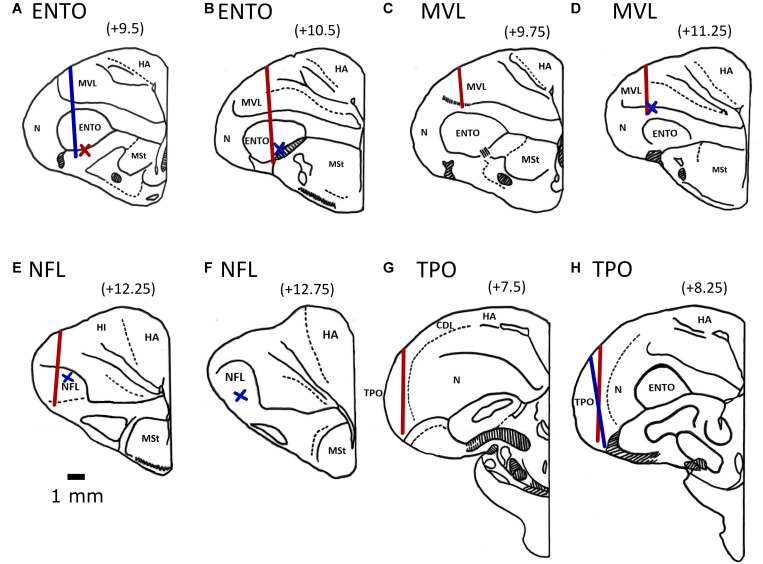
Electrode track position reconstructions for the two ENTO birds at AP + 9.5 (A) and AP + 10.5 (B), the MVL bird at AP 9.75 (C) and two birds at AP + 11.25 (D), two NFL birds at AP + 12.25 (E) and one bird implanted at AP + 12.75 (F), the TPO bird implanted at AP + 7.5 (G) and two birds implanted at AP + 8.25 (H). Both left and right electrode tracks are displayed on the same section. Tracks for birds with implants in the left hemisphere are displayed by the blue line and for birds with implants in the right hemisphere by a red line. We determined the termination point of electrode tracks that were unable to be recovered based on depth records. Termination points for birds with implants in the left hemisphere are displayed by a blue cross and for birds with implants in the right hemisphere by a red cross. All electrodes were advanced to the top of the intended region before recording began. The following are the brain regions as defined by Reiner et al. (2004): MSt, medial striatum; HA, hyperpallium apicale; HD, hyperpallium denso-cellulare; HI, hyperpallium intercalatum; Hp, hippocampus; MVL, mesopallium ventrolateral; N, nidopallium; NFL, nidopallium frontolaterale.